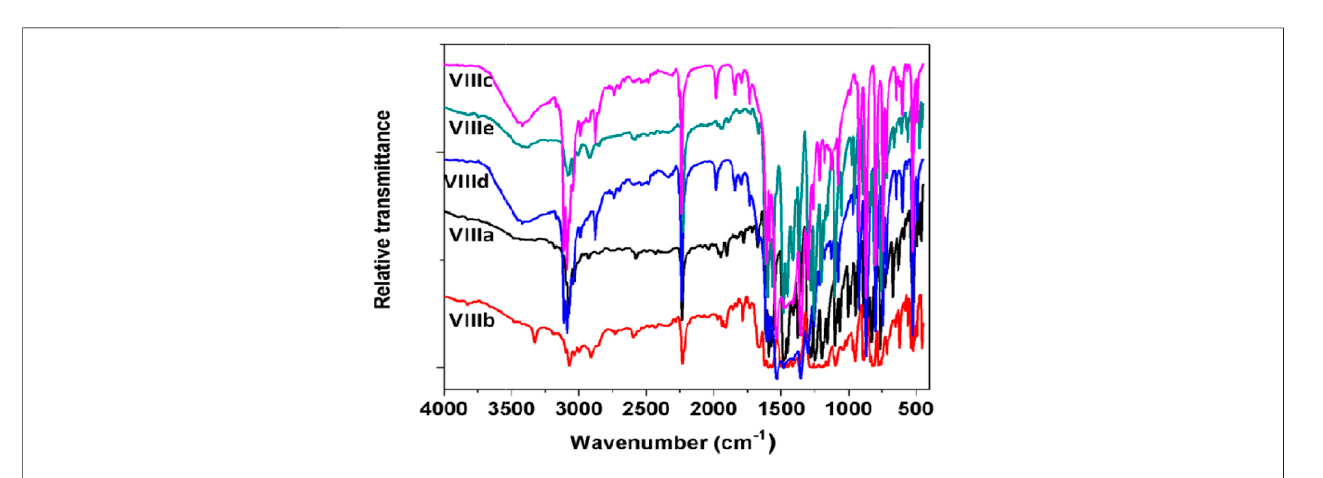
FIGURE 4 | FT-IR spectra of ( VIIIa-e ) phthalonitrile ligands.